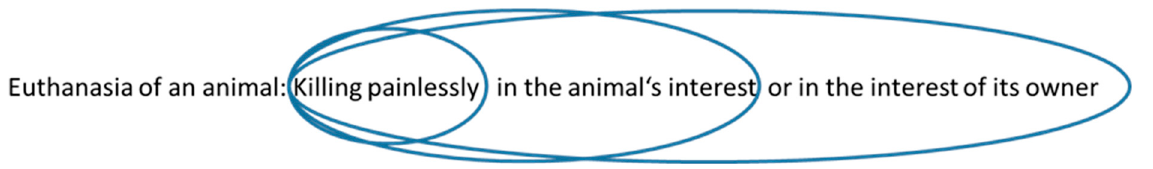
Figure 1. Definitions of euthanasia.